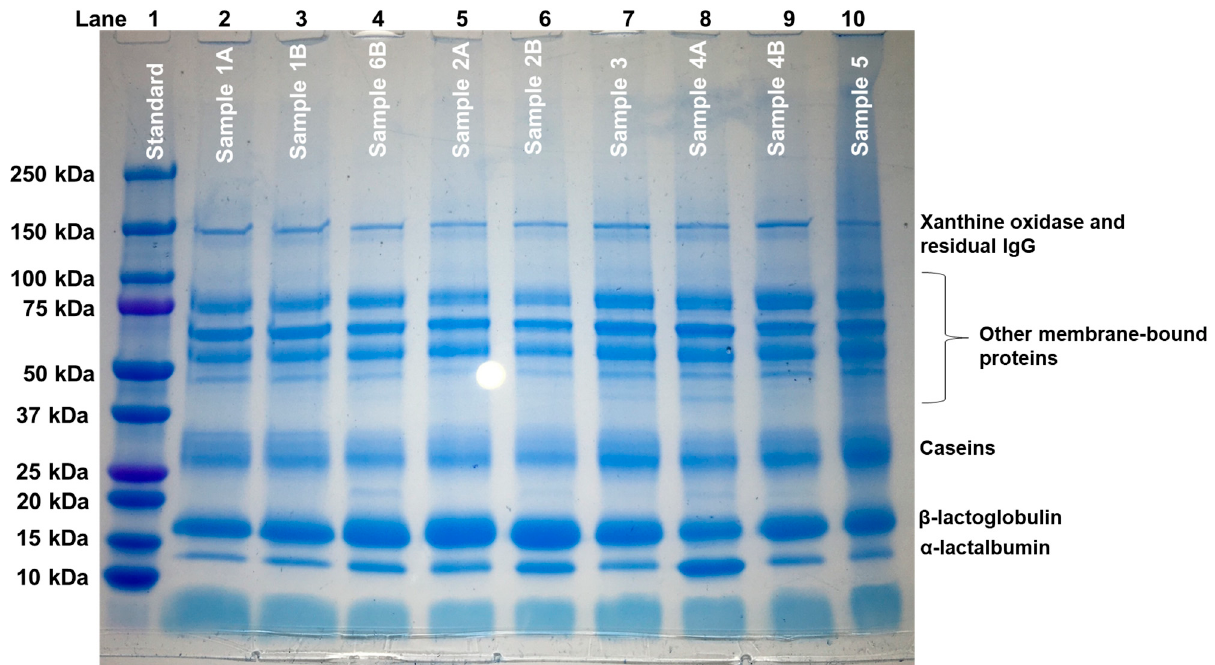
Figure 2. SDS-PAGE profile of whey protein phospholipid concentrate (WPPC) from different